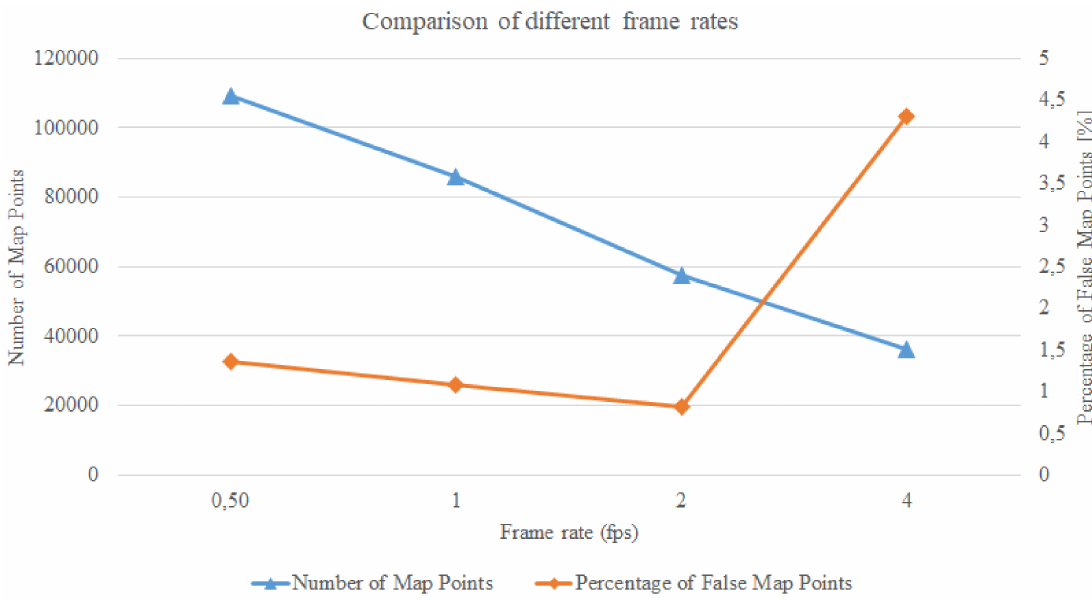
Figure 9. The influence of the frame rate on the Number of Map Points and the Percentage of False Map Points .